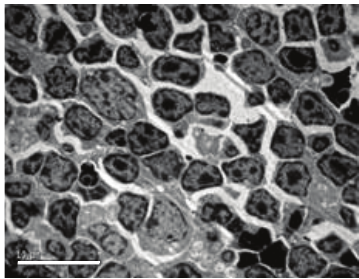
Figure 4: Model control group—12 hours in SAP experiment thymus (apoptoic cells obviously increase in thymus), Electron microscope × 1850.